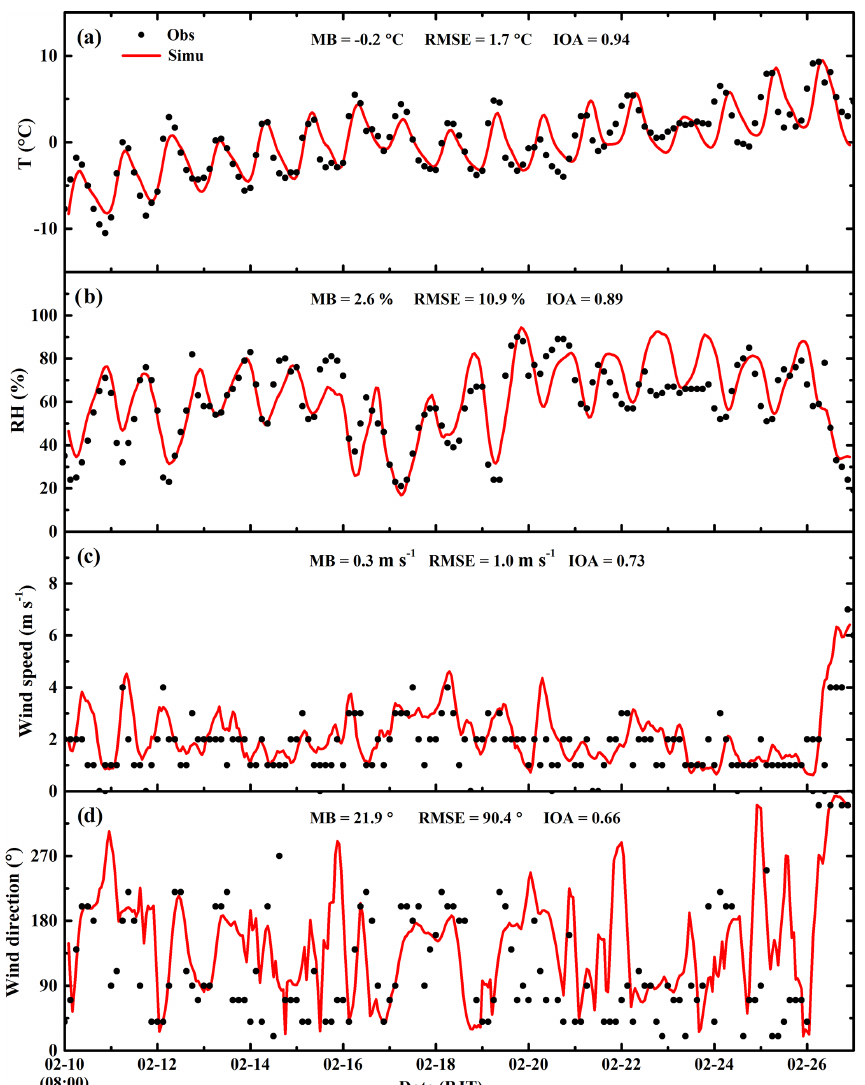
Figure 3. Temporal variations in simulated (red line) and observed (black dots) meteorological parameters of near-surface (a) temperature, (b) relative humidity, (c) wind speed, and (d) wind direction averaged at 12 meteorological sites in Beijing from 10 to 27 February